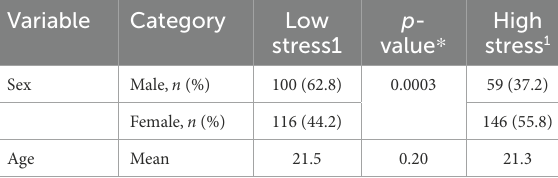
TABLE 4 Differences in academic stress (low vs. high) by sex and mean age in medical students at Zacatecas Autonomous University,